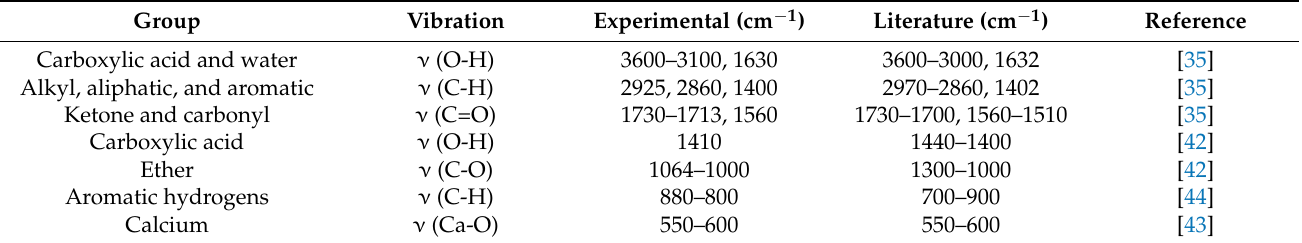
Table 3. Main vibrations of the compounds present in the FTIR spectra of raw materials and biochars.